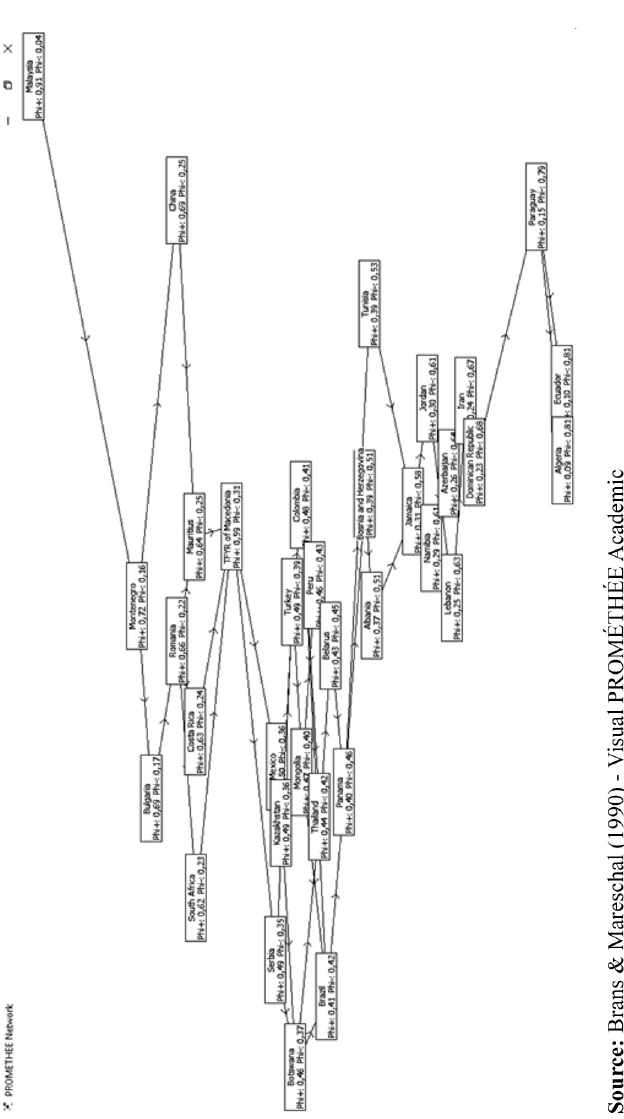
Figure 4. Adaptation from GAIA screen